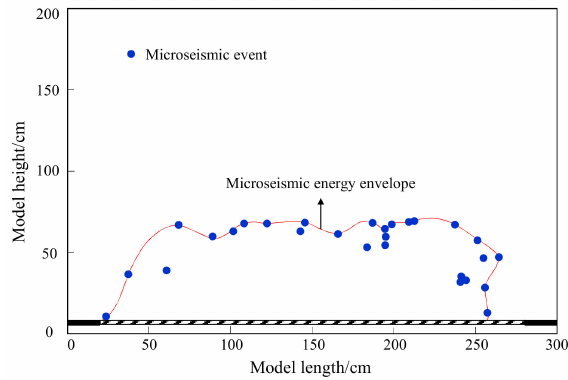
Figure 11. The microseismic energy envelope is drawn.